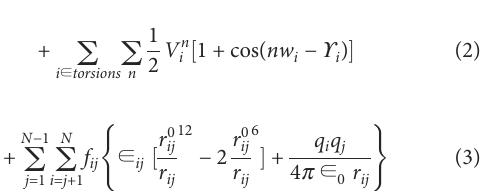
Equation 1. AMBER Force Field Formula (adapted from Case et al. AMBER9 Manual for Electrical Potential Across Protein.